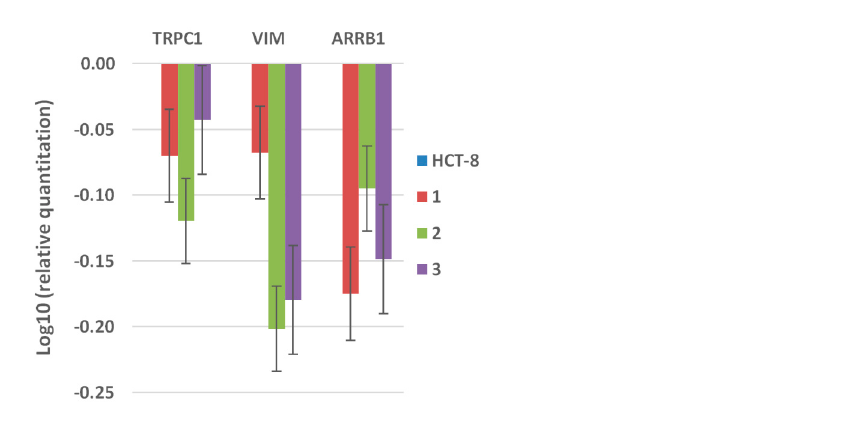
Figure 7. Relative quantification of the expression of TRPC1, VIM, and ARBB1 hypoxia-markers in HCT-8 cell line (expression was normalized with GAPDH gene).